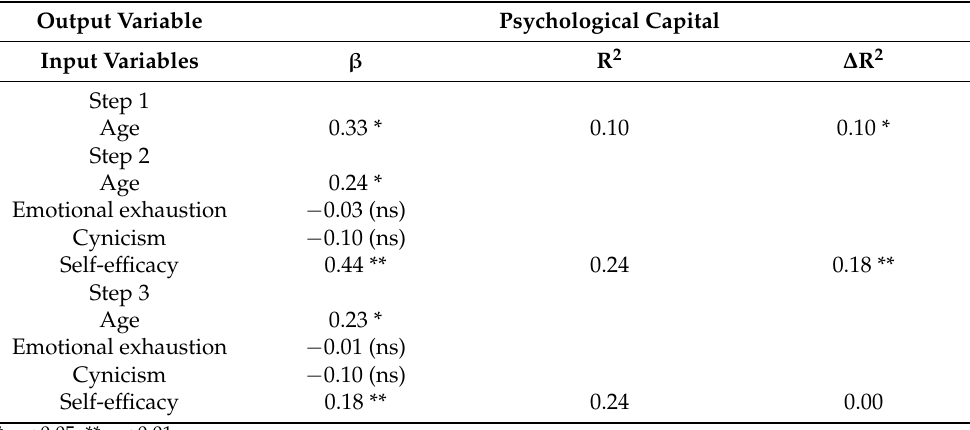
Table 3. Hierarchical regression analysis with psychological capital as output